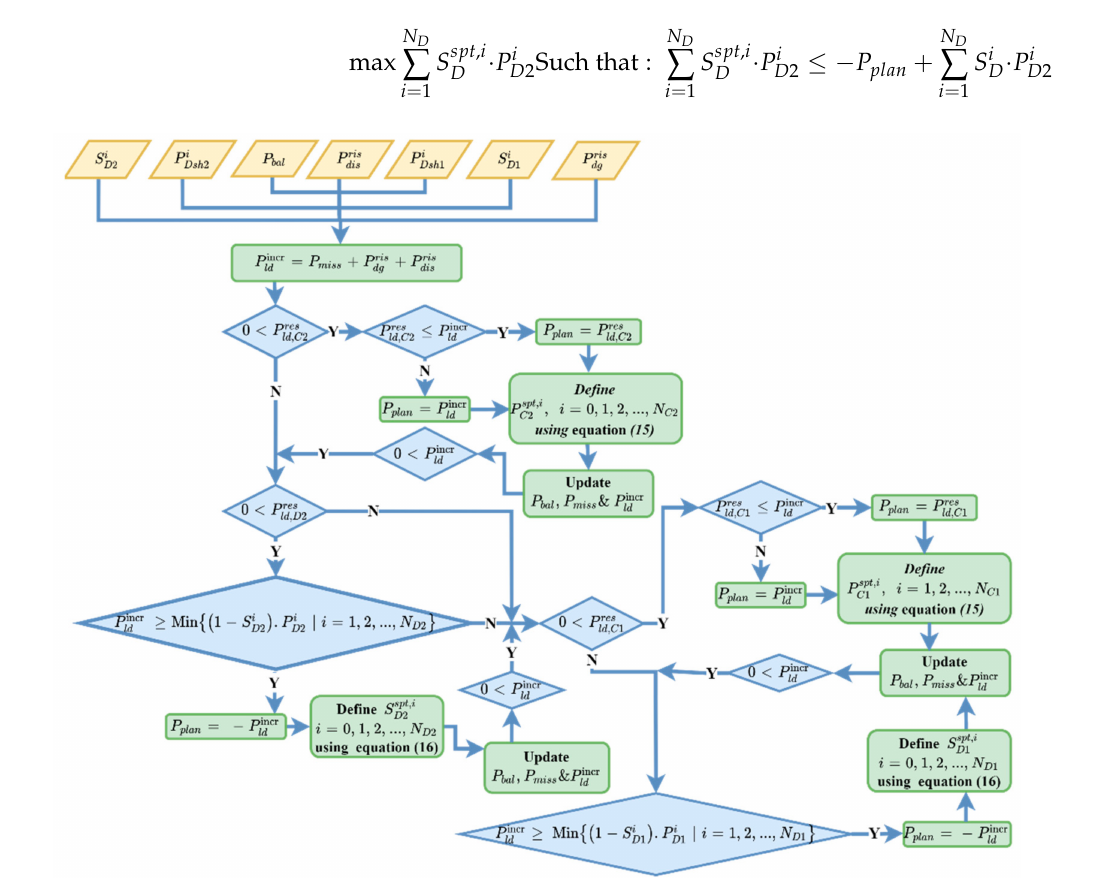
Figure 11. Flow chart of the load restoration